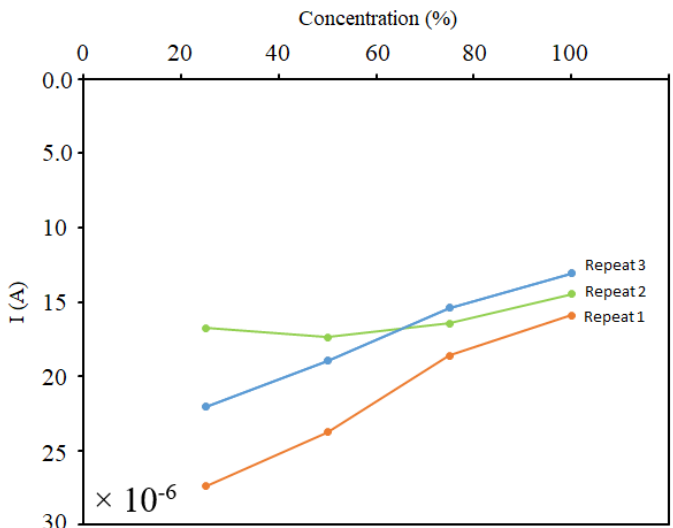
Figure 15. Analysis results of three repeats of testing current variations in different concentrations of neutrophils.